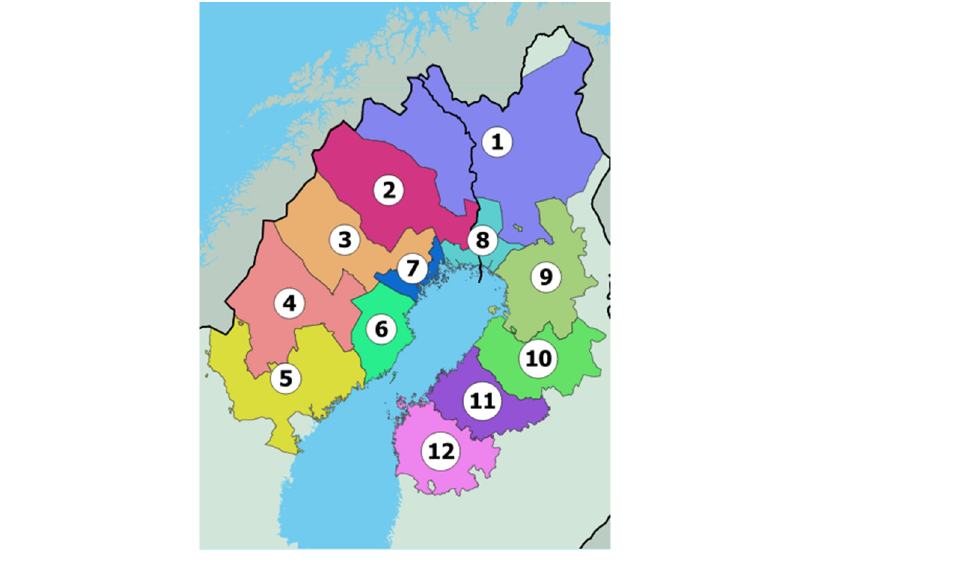
Figure 3. Allocation of municipalities into twelve calculation groups.